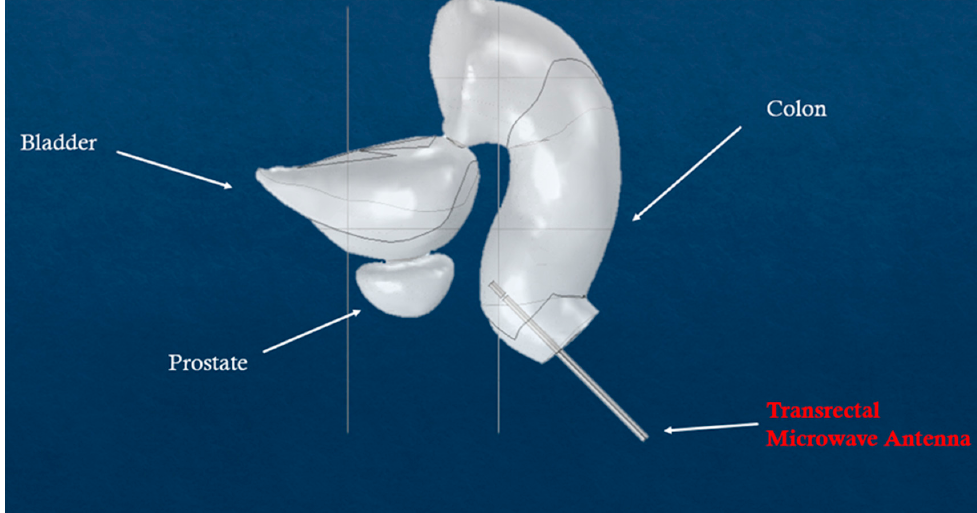
Figure 8. Simulated scenario of microwave-induced hyperthermia for prostate cancer.